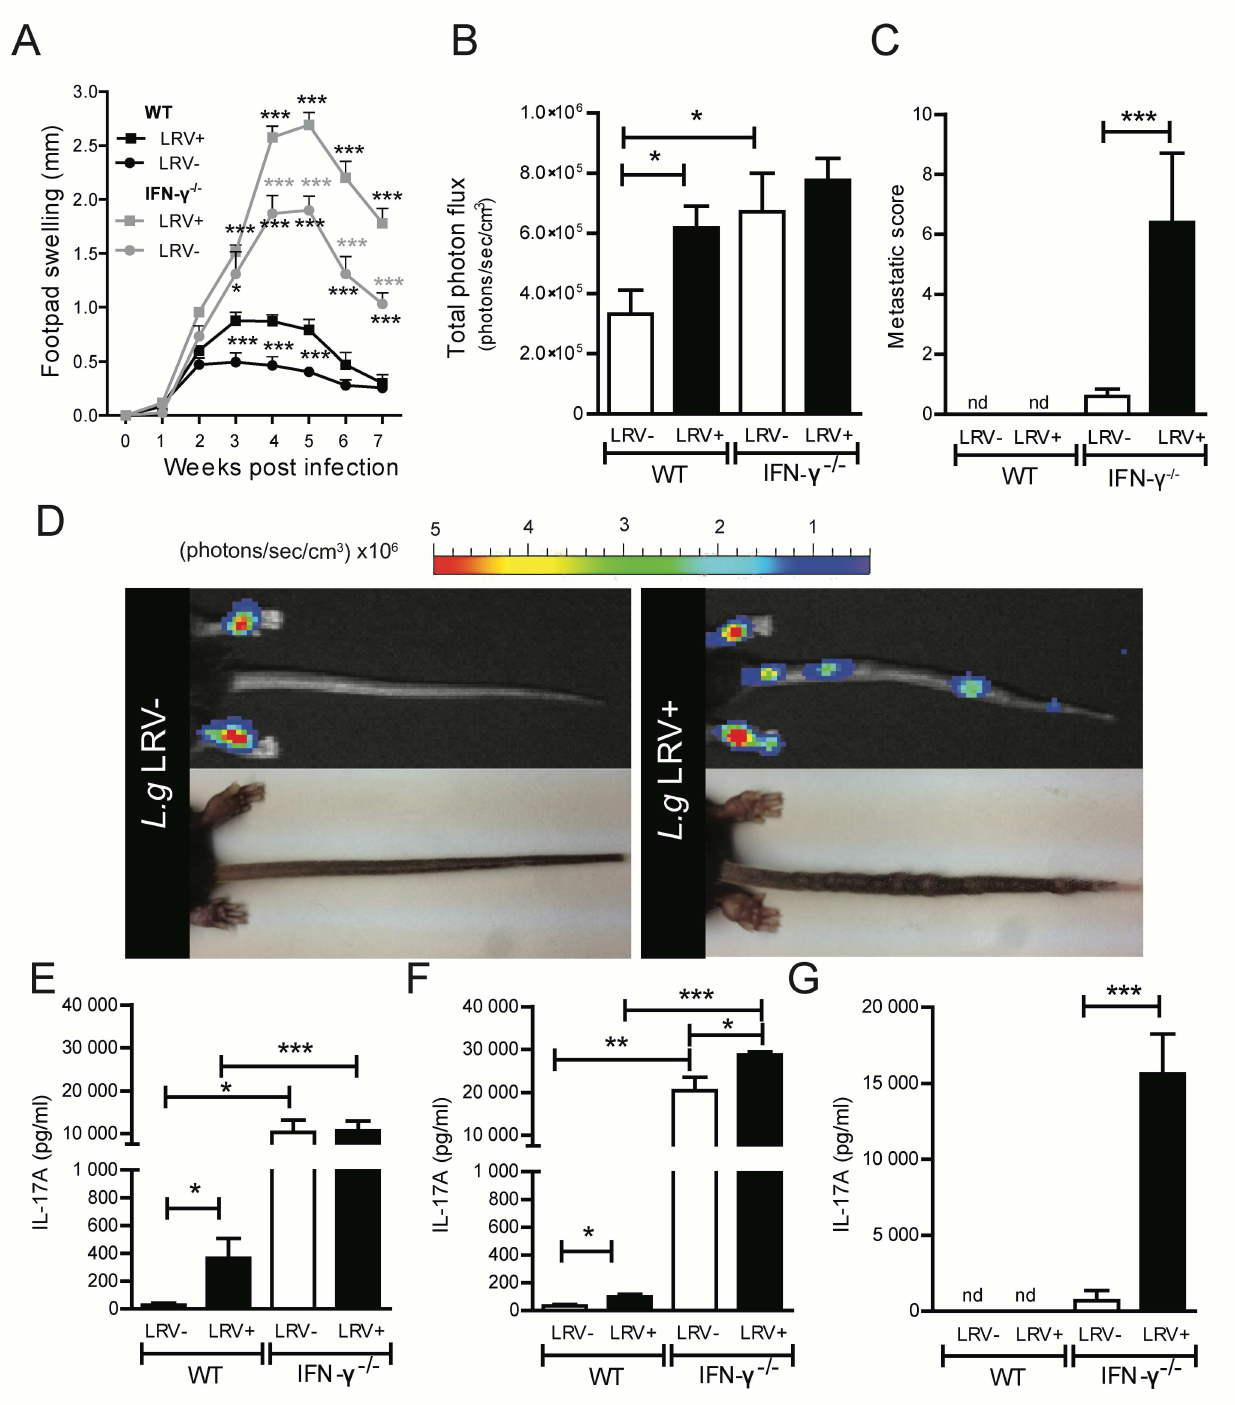
Fig 3. LRV1-dependentinfectious metastasisoccurs in the absenceof IFN- γ . Mice deficient in IFN- γ and their WT controls (C57BL/6)were infected in the hind footpads with LRV1+ or LRV1- L . g stationary-phasepromastigotes. (A) The change in footpad swelling was measured weekly as a proxy for disease progression.Statistical analysis is indicatedfor comparisons betweenWT LRV1+ infected mice in black and IFN- γ -/- mice in grey. (B) At the peak of WT infection (week 4) in vivo parasiteluminescence was determined as a measureof parasite burden. (D) At 7 weeks of infection, LRV1+ L . g infected IFN- γ -/- mice developed secondarylesions in theirtails which were positive for parasiteluminescence. (C) The numberof secondary lesions was countedin all groups of mice. (E) At 4 weeks post infection, lymphocytes were extracted frompopliteal